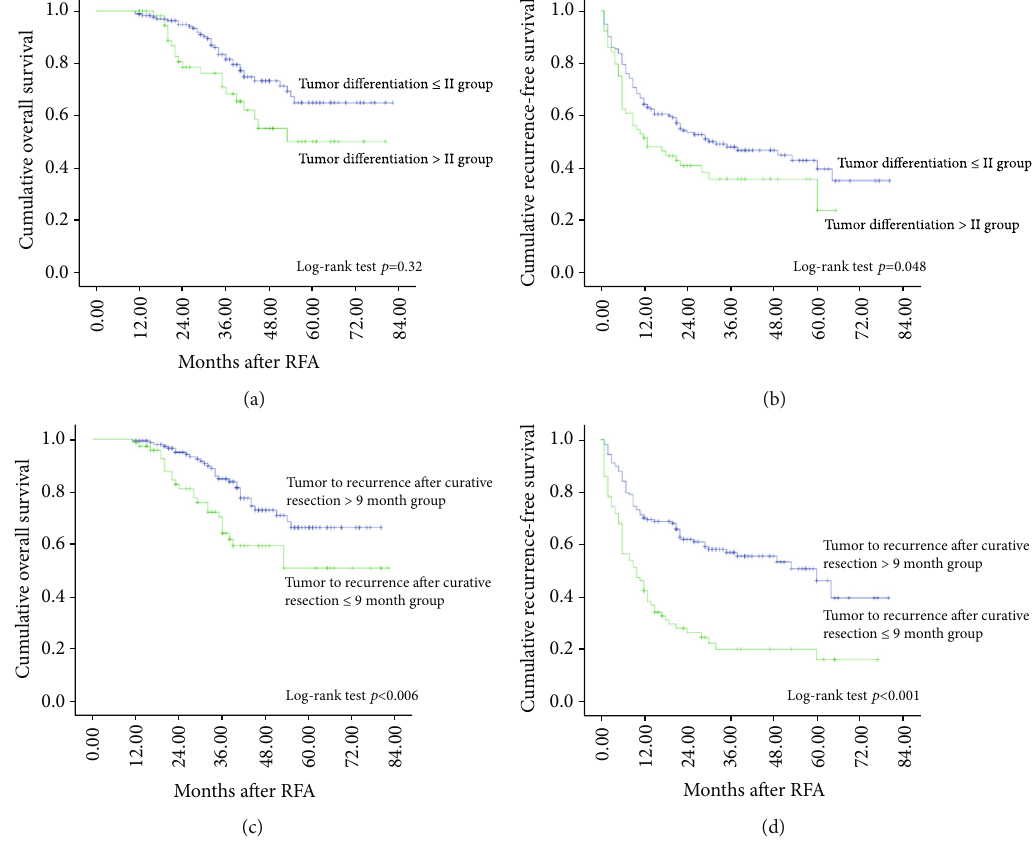
Figure 1: Worse primary tumor di ff erentiation and short time to recurrence after curative resection bode poorly for clinical outcomes of recurrent hepatocellular carcinoma undergoing radiofrequency ablation. Univariate analyses of primary tumor di ff erentiation demonstrated that worse tumor di ff erentiation was associated with poorer overall survival (OS) rates (a) and poorer recurrence-free survival (RFS) rates (b) (Kaplan-Meier and log-rank tests). Prognostic performance of primary tumor di ff erentiation was signi fi cant for both OS and RFS ( p = 0 : 032 and p = 0 : 048 , respectively). Univariate analyses of time to recurrence after curative resection demonstrated that short time to recurrence was associated with poorer OS rates (c) and poorer RFS rates (d) (Kaplan-Meier and log-rank tests). Prognostic performance of time to recurrence after curative resection was signi fi cant for both OS and RFS ( p = 0 : 006 and p < 0 : 001 , respectively). Table 4: Time to recurrence after curative resection predictive value of OS and RFS using di ff erent cut-o ff